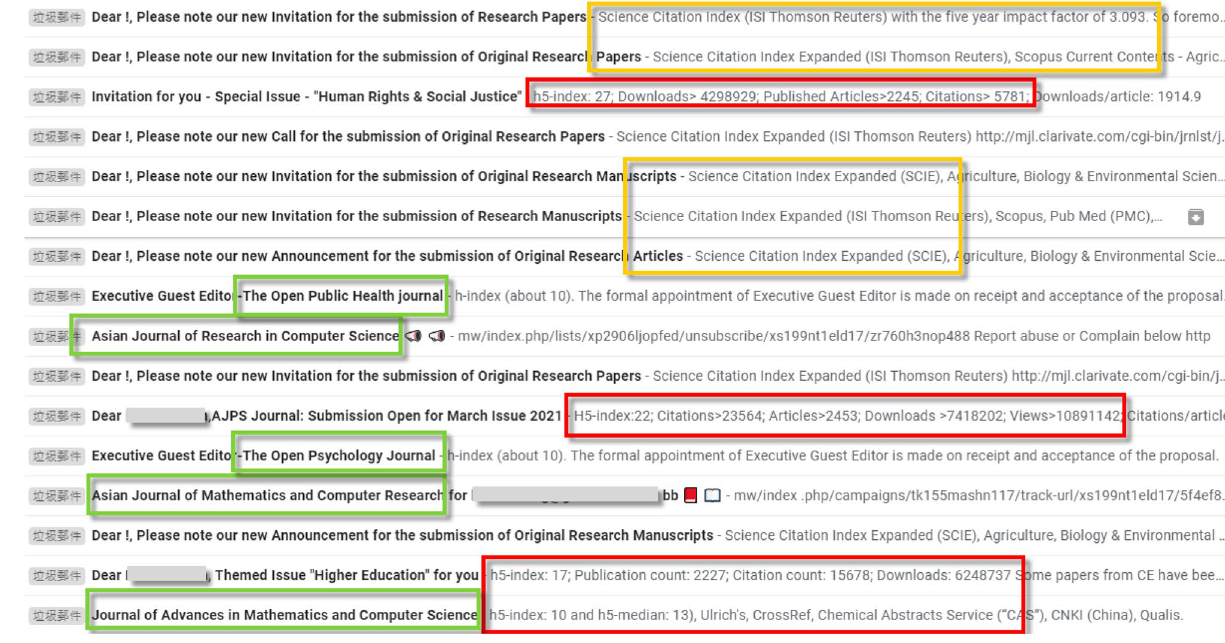
Figure 2. Examples of potentially misleading text in invitations sent to scholars to submit